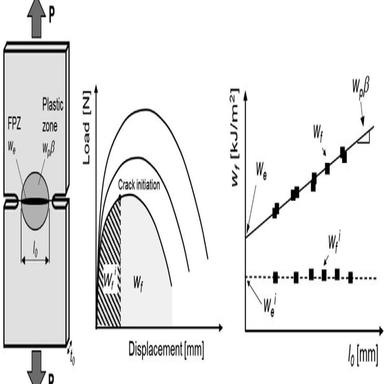
DENT specimen and experimental procedure for the determination of the essential work of fracture, we and the specific work for fracture initiation, we i .